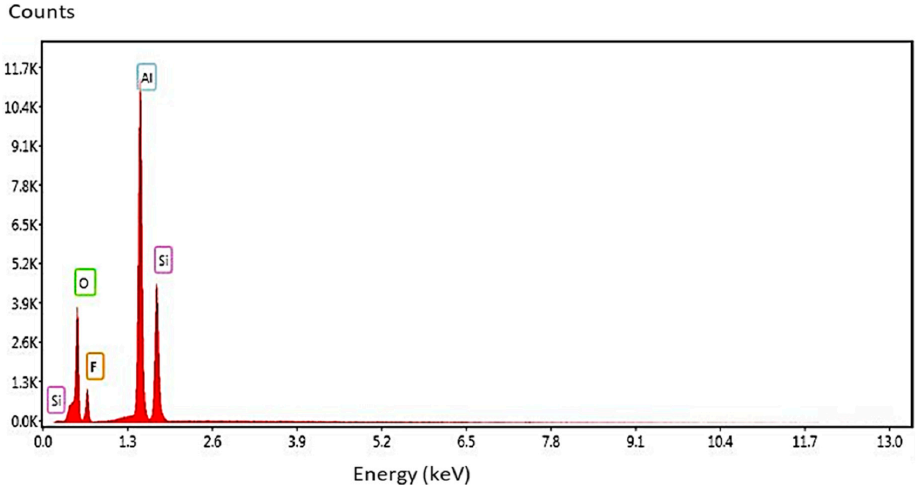
Figure 7. Energy dispersive X-ray (EDX) spectrum of topaz crystals. Table 5. Elemental compositions of different elements present in topaz crystals measured by CF-LIBS and EDX techniques.